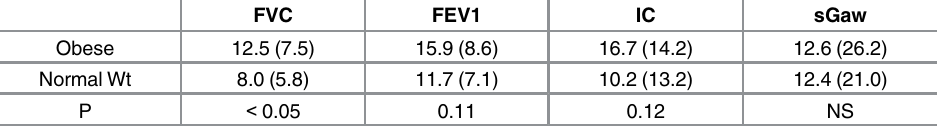
Table 3. Mean (SD) decrements in lung function variables (delta % fall) expressed as ((Pre-Post Ozone)/Pre Ozone) – (Pre-Post Air)/Pre Air)) X